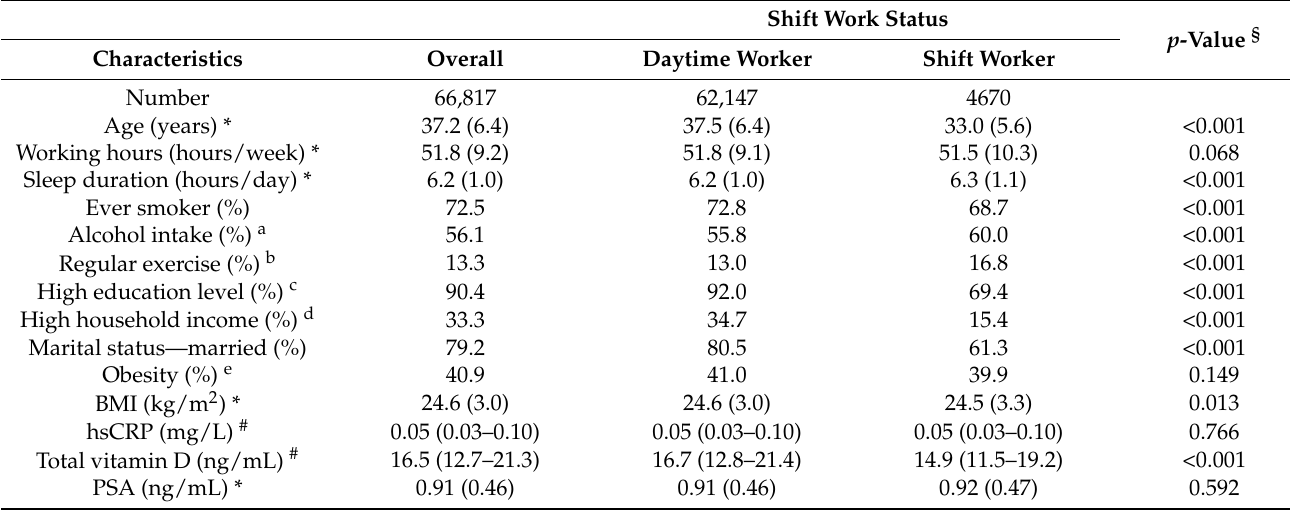
Table 1. Baseline characteristics of study participants by shift work